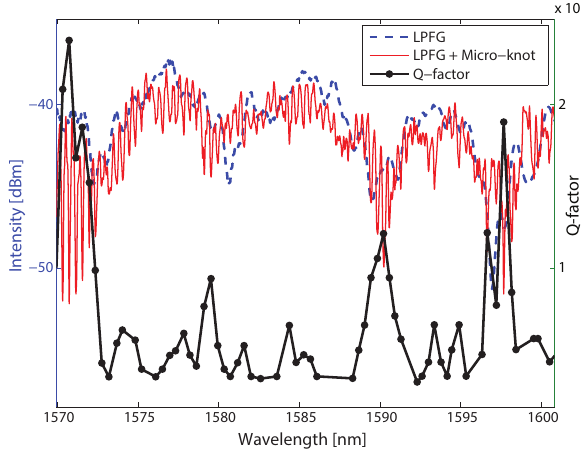
Figure 5. Measured Q-factor of the micro-knot as a function of the wavelength. The increase in the Q-factor of the micro-knot at the LPFG resonances indicates that high-order modes have stronger evanescence wave